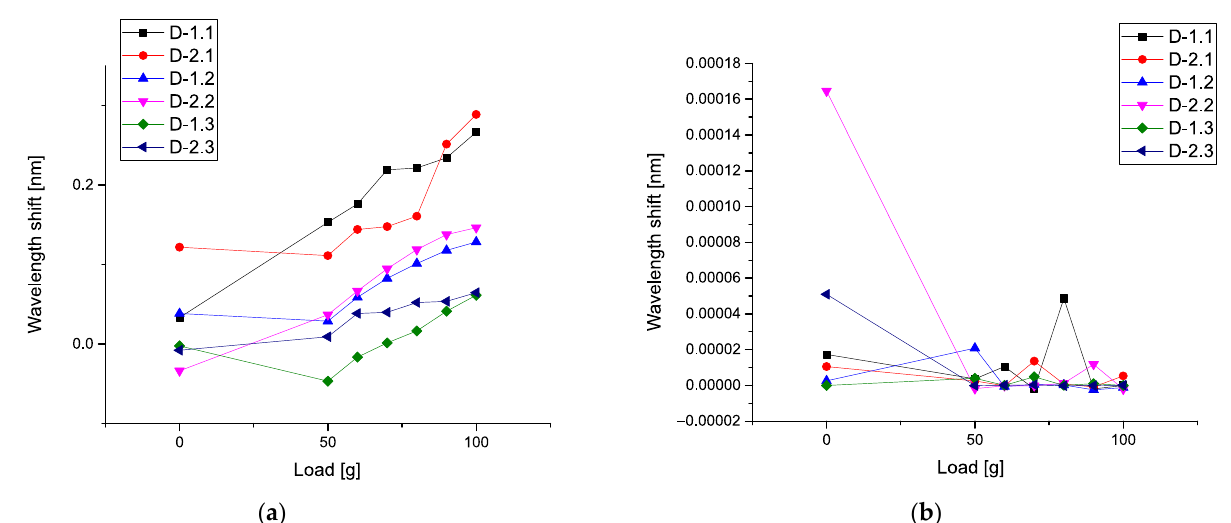
Figure 8. ( a ) Calibration curves calculated for mean values of the first-order correlators; ( b ) mean values of the second-order correlators.